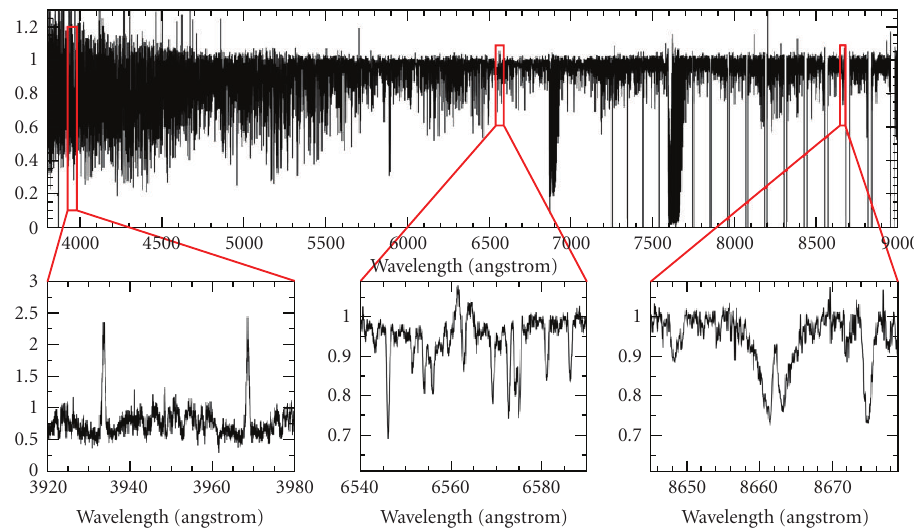
Figure 1: An example spectrum from the SES. What is shown is the V = 9 . 0 mag K0III RS CVn binary XX Triangulum. Exposure time was 1 hour, spectral resolution is 55,000, an S/N ratio of 120 : 1 was achieved. The top panel shows the full spectrum (note the increasing order gaps redwards of 725nm). The lower panels zoom into the Ca II H&K region, Balmer H α , and one of the Ca II infrared